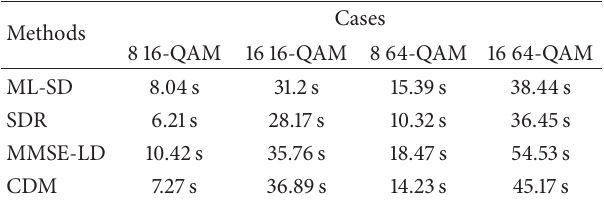
Table 1: Average computational time for different methods under different